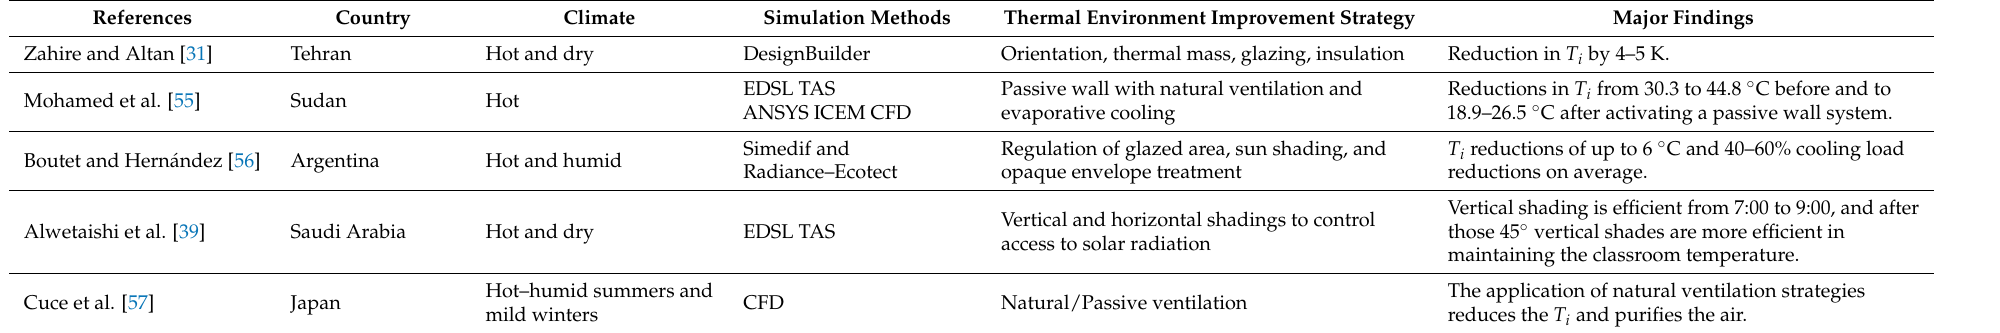
Table 2. Summary of passive design strategies research in school/educational buildings with their major